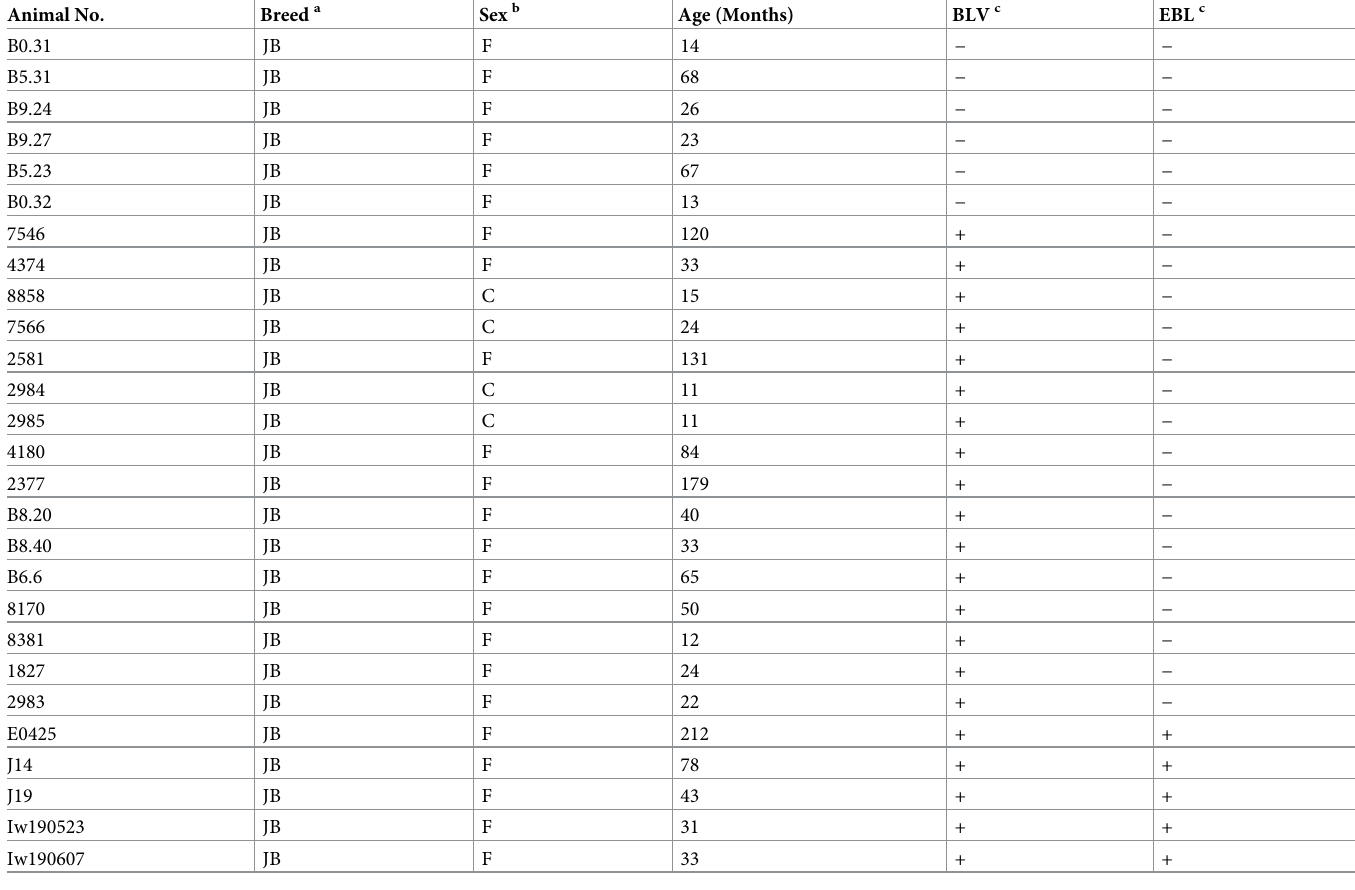
Table 1. Animals used in this study. Animal